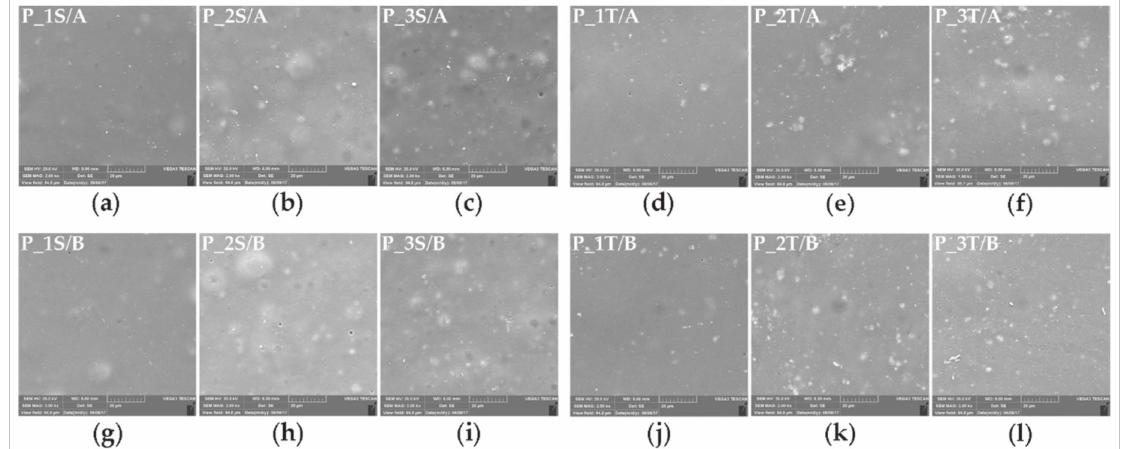
Figure 5. SEM micrographs of paper-adhesive samples with nano-enhanced PVAc adhesive